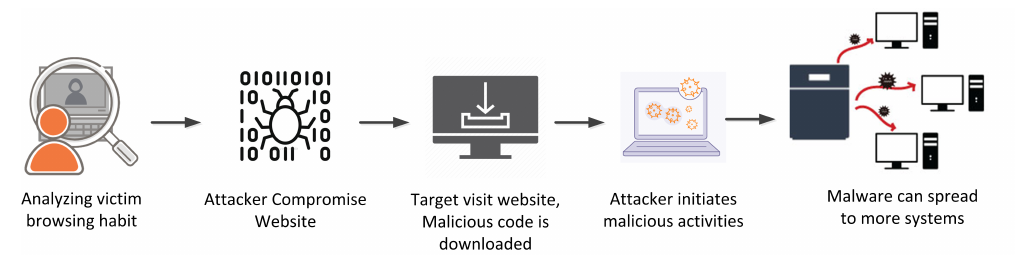
Figure 5. Steps of a water hole